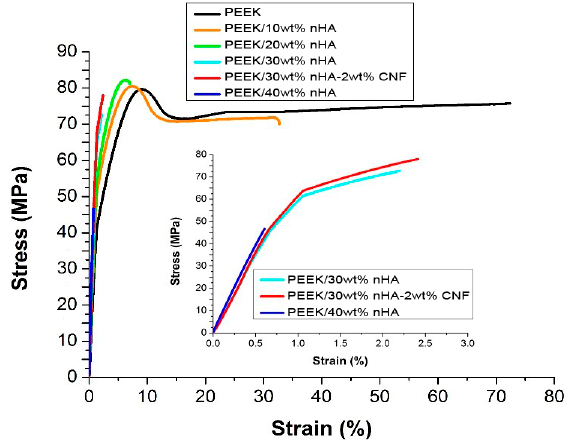
Figure 15. Tensile stress-strain curves of PEEK/nHA nanocomposites prepared by melt-compounding followed by injection molding. Reproduced from [62] with permission of Royal Society of Chemistry.